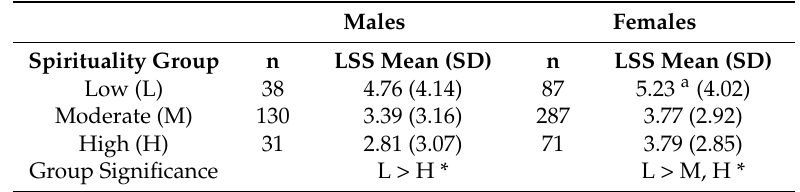
Table 4. Differences among differentially spiritual groups of males and females